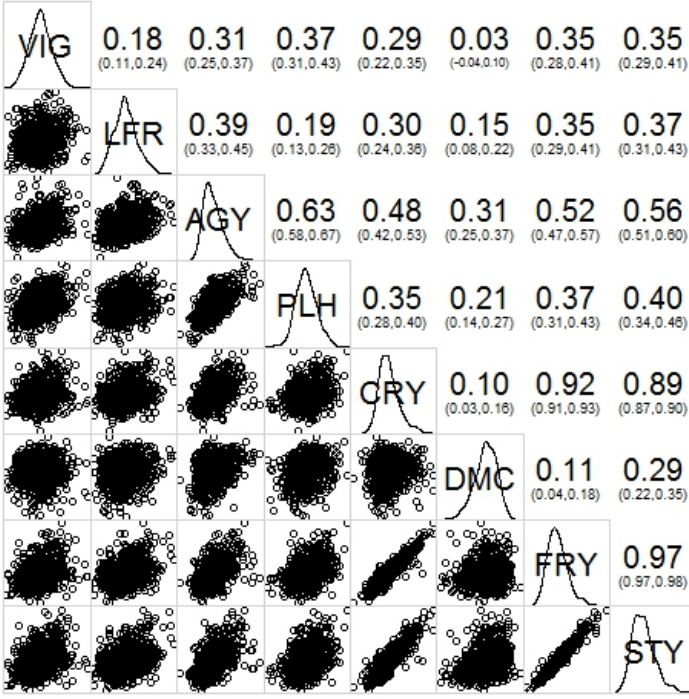
Figure 1 - Pairwise genotypic correlation coefficients between eight agronomic traits evaluated in cassava genotypes. VIG: plant vigor; LFR: leaf retention; AGY: above-ground yield; PLH: plant height; CRY: commercial fresh root yield; DMC: dry matter content; FRY: total fresh root yield; STY: starch